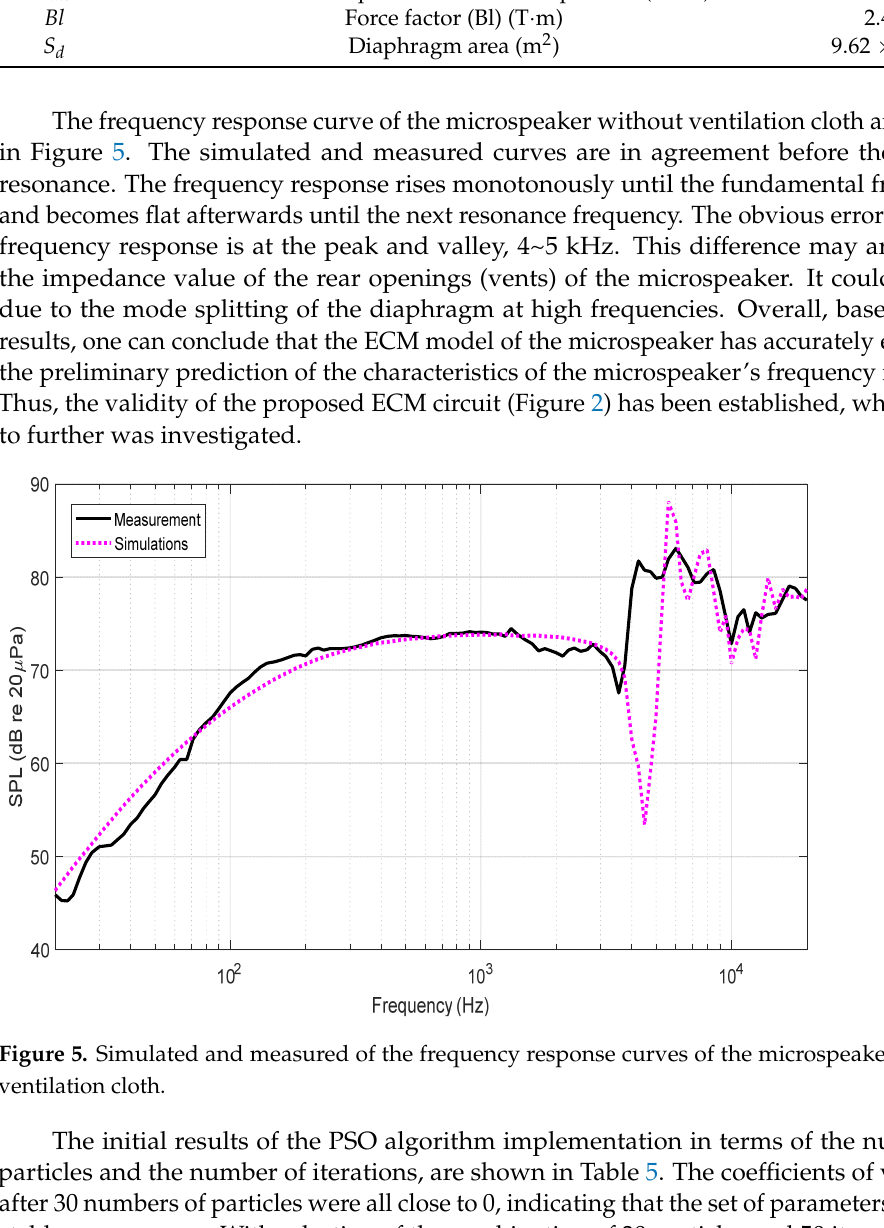
Table 5. Optimization of acoustic resistance of ventilation cloths, particle number, and coefficient of variation (Remarks: The upper and lower boundaries are in the range of 10 times the original pa- rameter value (10~0.1)).